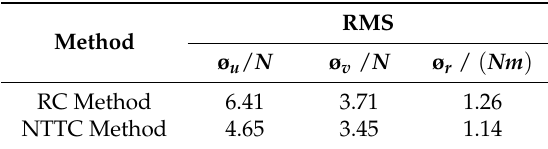
Table 2. Control input comparisons of RC and NTTC